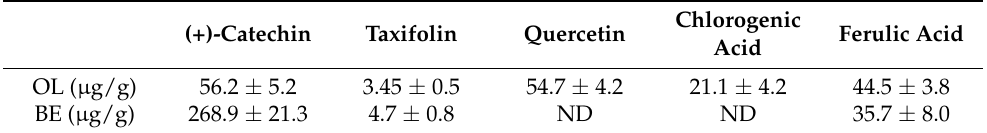
Table 2. Concentrations of polyphenol compounds in freeze-dried water extract of oxidation-treated leaves (OL) and branches (BE) (ND, not detected).